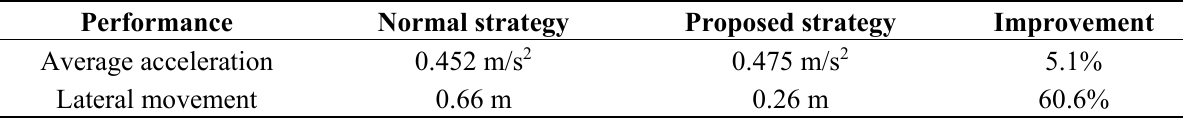
Table 5. Performance of acceleration slip regulation on variation friction coefficient road